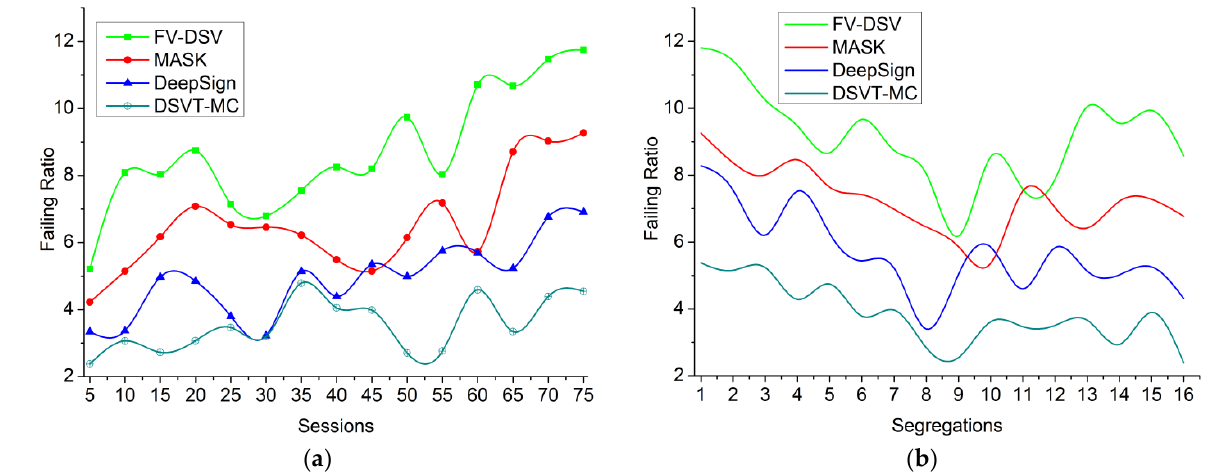
( b ) Figure 10. Authentication Success Rate for ( a ) different session rate ( b ) Segregation. 4.3.2. Verification Failure Ratio In this proposed technique, the authentication verification failure ratio is computed to conceal users’ information between the biometric systems and remote devices, without providing digital certificates during online and offline signature approval in mutual ses- sions. The computation of dynamic signature verification is performed to prevent ad- versarial forging activities, and verification failure is identified in both 𝑂𝑁 𝑆𝑉 and 𝑂𝐹𝐹 𝑆𝑉 . This authentication is performed using security metrics such as the signing bit, key, and size for verification time intervals to validate online and offline signature authentication for appropriate instances. Based on the verification, online and offline authentication